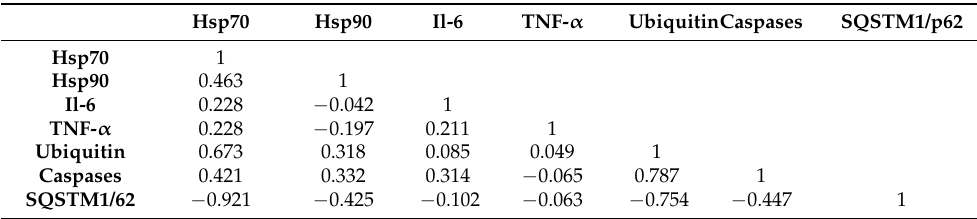
Table 2. Correlation analysis between biochemical parameters examined with Western blot and dot blot analysis.